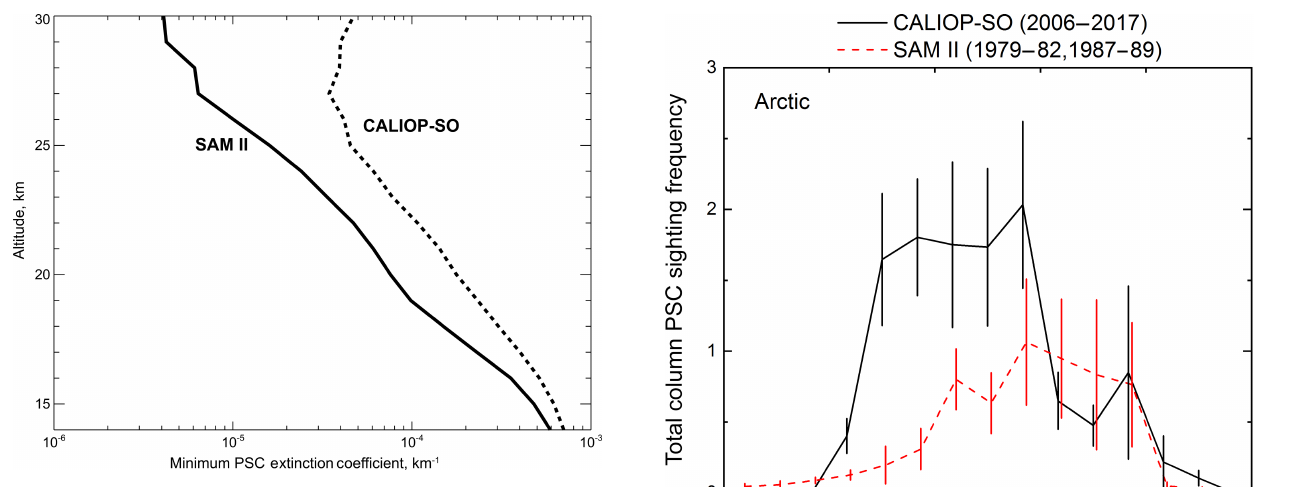
Figure 28. Vertical profile of season-long minimum (first per- centile) values of adjusted ( × 1 . 3) 1µm α particulate for SAM II Antarctic PSCs (solid curve) and calculated 1µm α particulate for CALIOP-SO Antarctic PSCs (dotted curve).